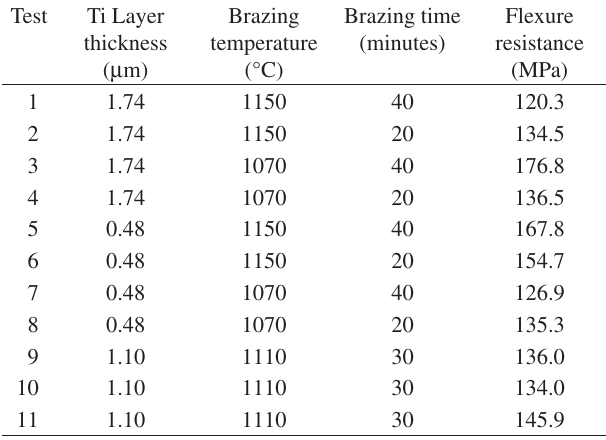
Table 1. Input variable and flexure resistance